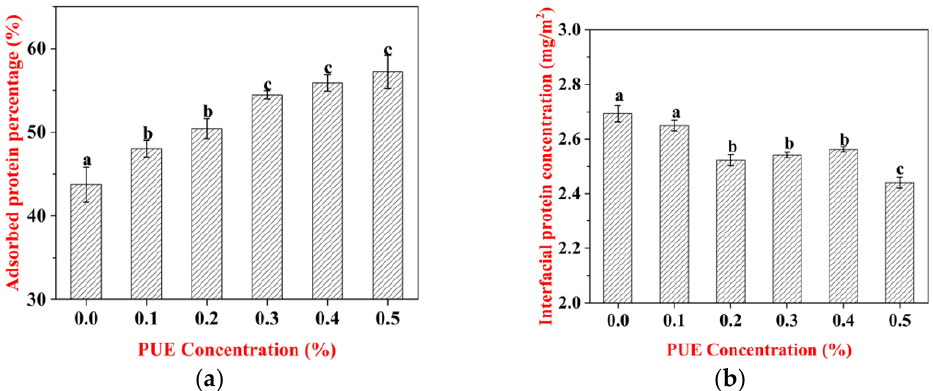
Figure 4. Surface properties of emulsions stabilized by WPI only or WPI – PUE composites with different concentrations of PUE (from 0.1% to 0.5%). ( a ) Interfacial protein concentration and ( b ) adsorbed protein percentage.